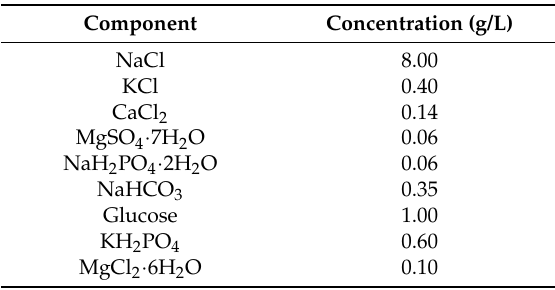
Table 1. Composition of Hanks’